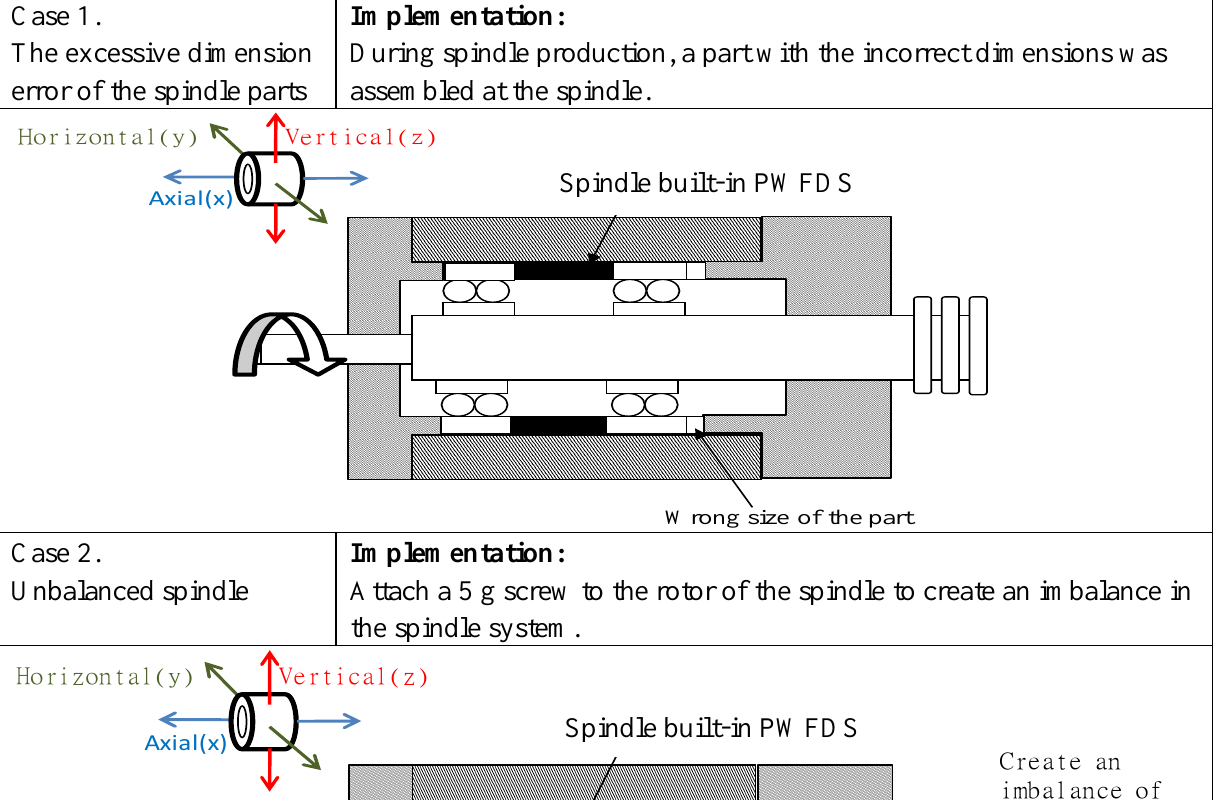
Table 3. Simulation of fault